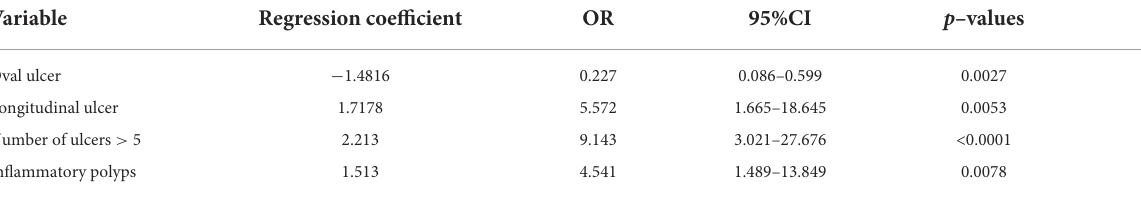
TABLE 6 The multivariate logistic regression analysis and scores of model 1.